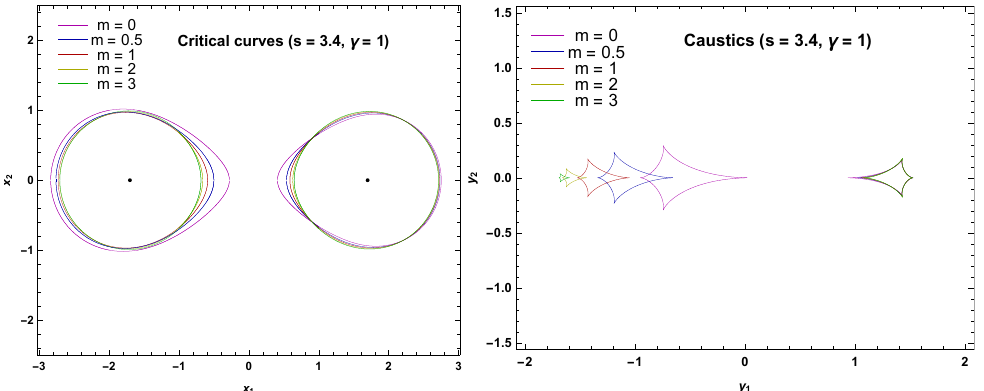
Figure 1. Critical curves and caustics in the equal-strength binary, wide separation. Here and in the following figures the lens on the left side has n = 1 and the lens on the right side has variable m , coherently with Equation (5).